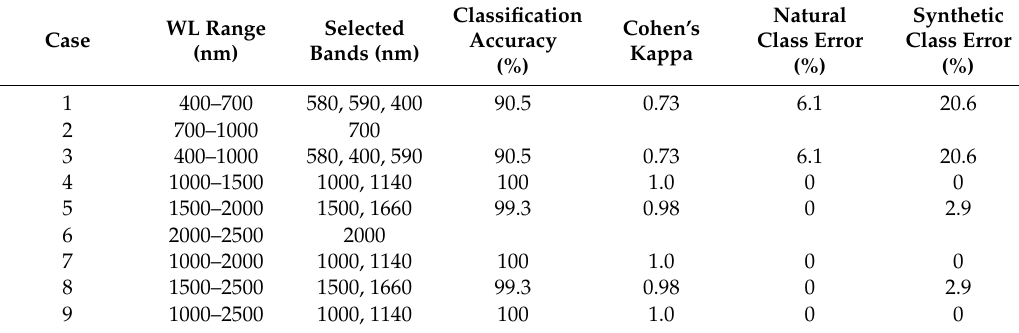
Table 3. Leave-one-out classification performance considering the spectra of fibers dyed with natural Madder or synthetic red